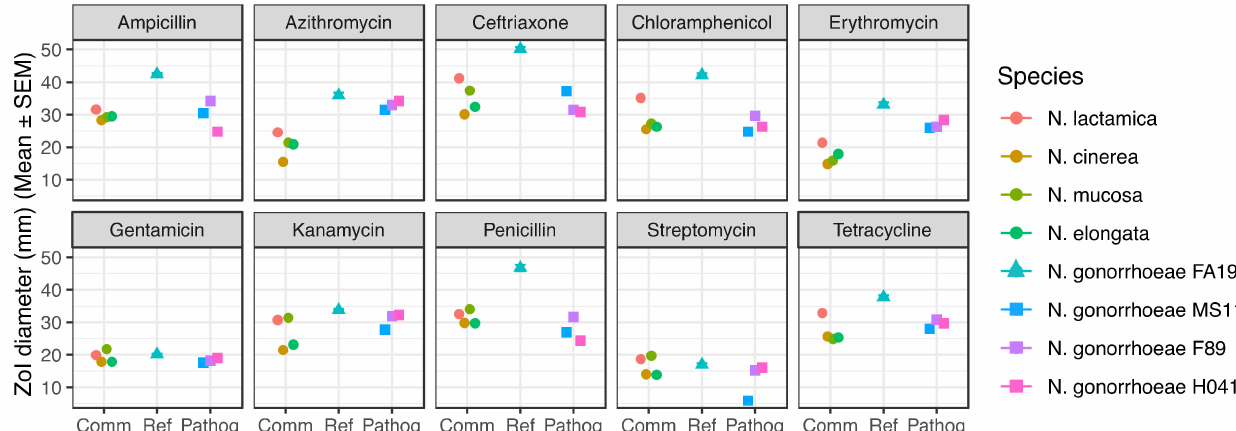
Figure 1. Antibiotic disk diffusion assays (DDA) on 10 antibiotics demonstrate antibiotic resistance profiles of Neisseria species, grouped as commensal (Comm, circles), reference (Ref, triangles) and pathogenic (Pathog, squares). Means ( ± SEM) of zone of inhibition (ZoI) diameters (mm) from 3 independent experiments, each performed with three biological replicates are shown. Comm, commensal; Ref, reference N. gonorrhoeae FA19; Pathog, pathogenic.